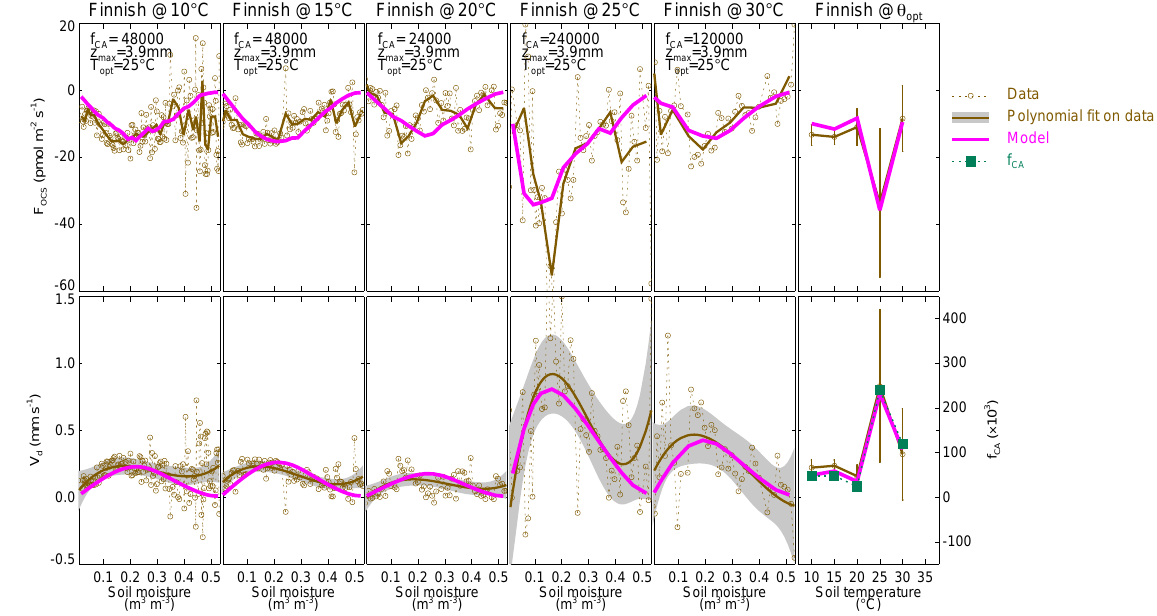
Figure 10. Same as Fig. 9 but for an agricultural soil near Hyytiala in Finland (soil weight is